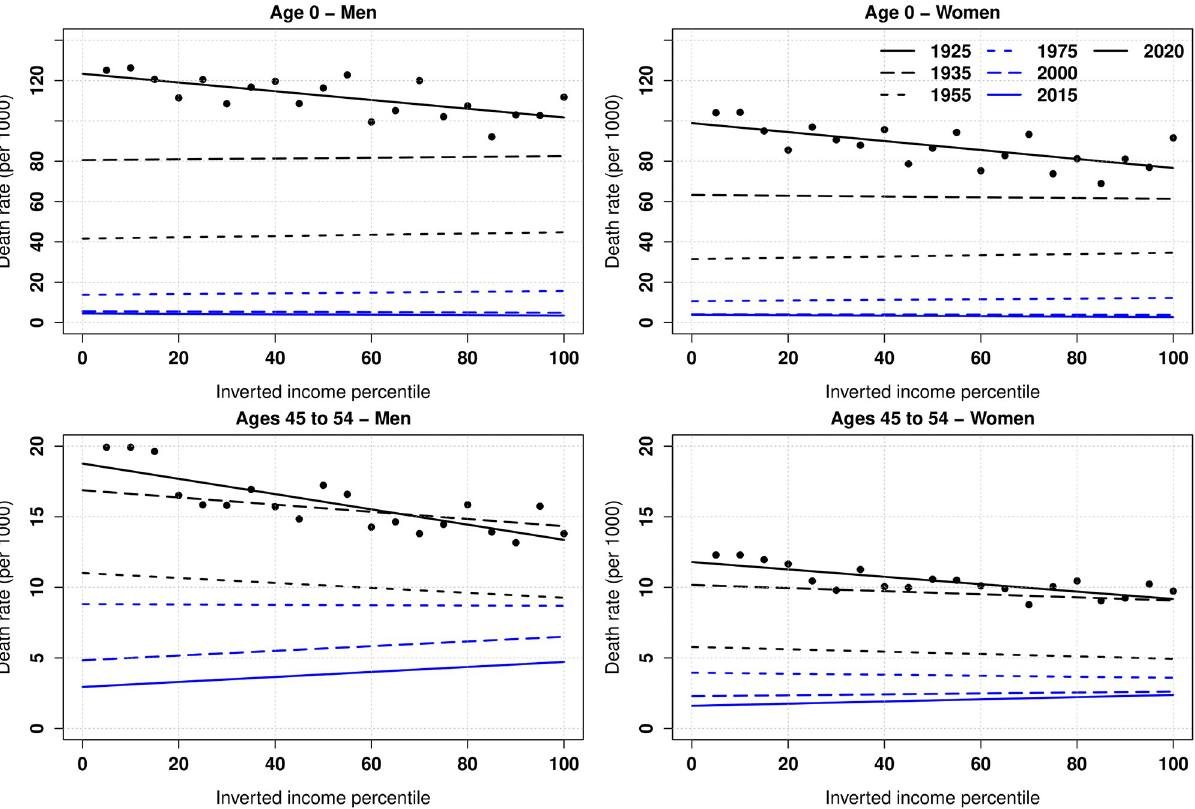
Fig 1. Death rates by inverted income per capita percentile. Lines represent the linear trend that fits the annual death rates per 1,000 for selected ages and sex across 20 income groups. A positive slope indicates that mortality decreases with income. In the S1 Appendix, figures for all age groups are provided for both men (S1 Fig in S1 Appendix) and women (S2 Fig in S1